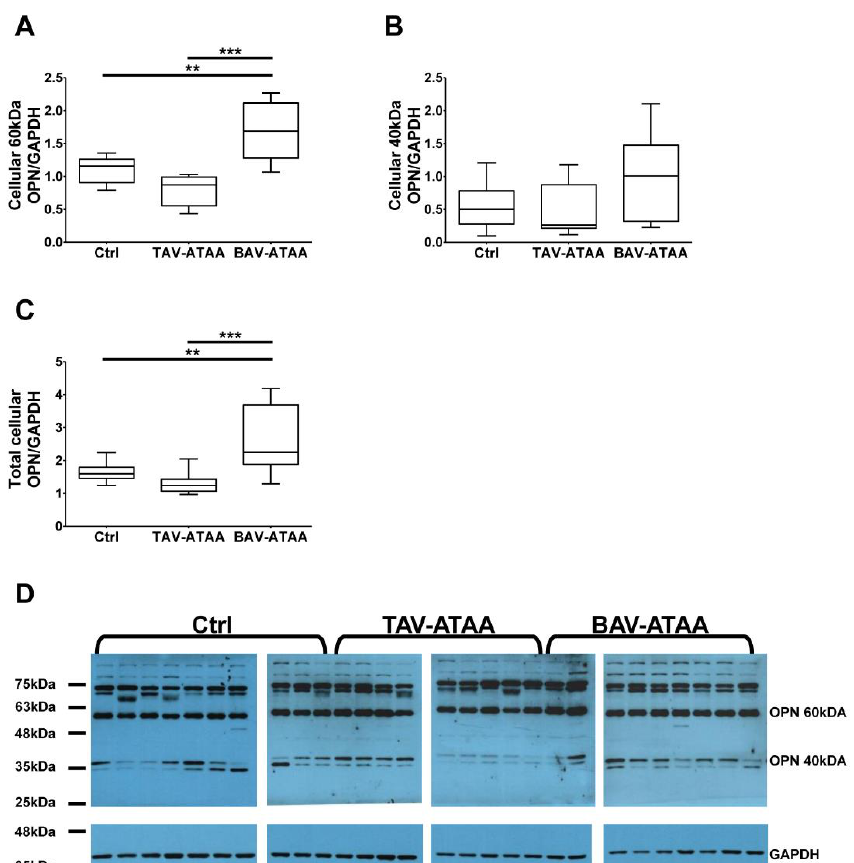
Figure 4. Expression pattern of OPN in isolated smooth muscle cells of aneurysmal and control tissue. ( A ) depicts the determination of uncleaved OPN expression in isolated smooth muscle cells (full length 60 kDa bands). In ( B ) the quantification of the expression of the cleaved 40 kDa band from aneurysmal and control smooth muscle cells is shown. In ( C ) the quantification of the smooth muscle specific total OPN expression is depicted (60 kDa and 40 kDa). In ( D ) the corresponding images of Western blot results for the detection of full length and cleaved OPN, as well as GAPDH (37 kDa) as loading control are shown (Control n = 10; TAV n = 10; BAV n = 10) (** < 0.01; *** < 0.001).